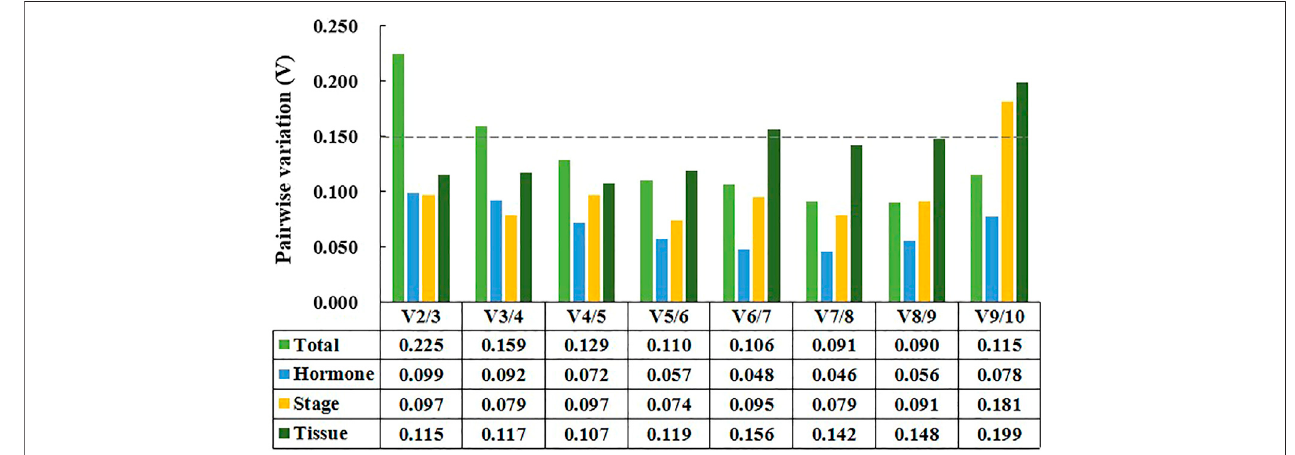
FIGURE 4 | Pairwise variation (Vn/Vn+1) calculated by for geNorm. Tissue represents samples from different tissues. Stage represents samples from chimeric leaves at different developmental stages. Hormone represents samples from tissue culture plantlet under different hormone treatments. Total represents samples from the above three experimental